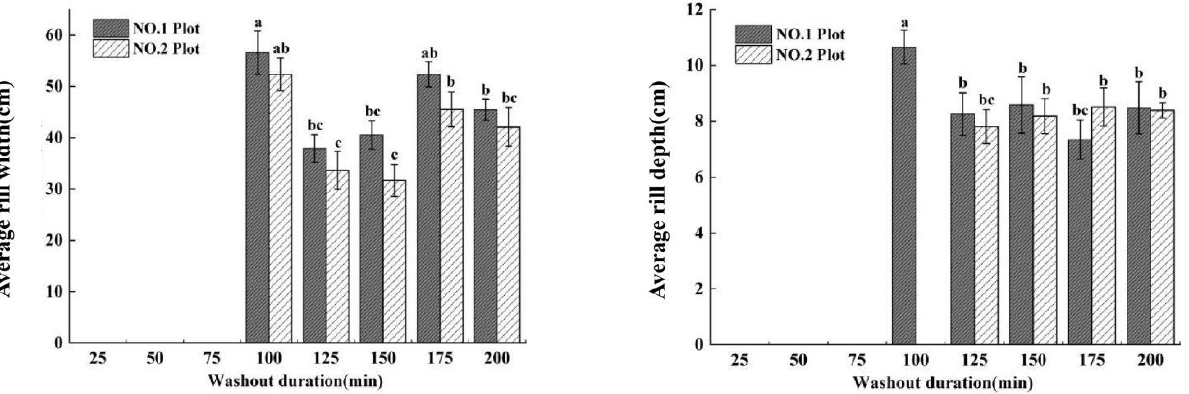
Figure 5. The changes in average rill width and depth of short-term heavy rainfall (No. 1 plot) and moderate rainfall (No. 2 plot) with washout duration increasing.